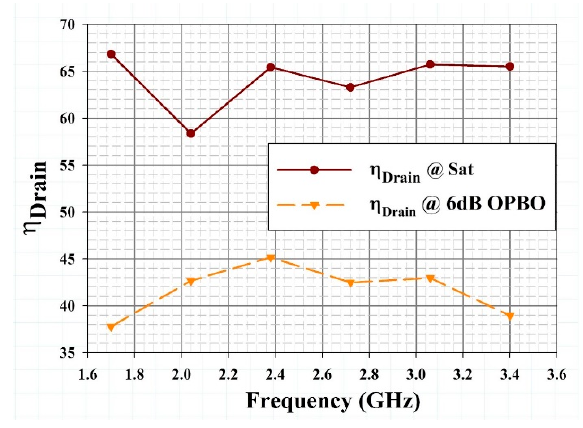
Figure 18. Measured drain efficiency at 6 dB OPBO and output power saturation for frequencies between 1.7 GHz and 3.4 GHz.